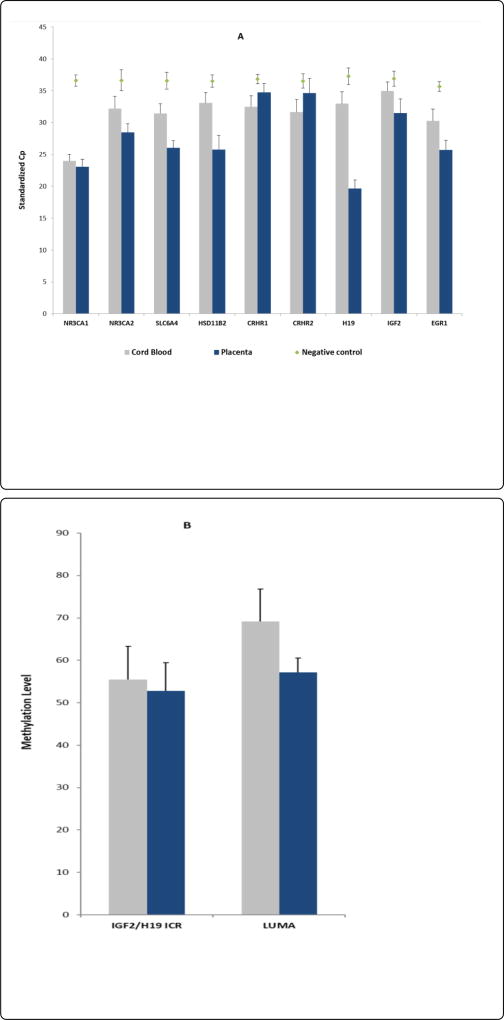
A: Gene expression values between umbilical cord blood and placenta tissue. Cp values measured, standardized, and averaged from all 49 samples. Error bars represent SD. Negative control errors bars represent 3SD.B: Methylation values between cord blood and placenta tissue.